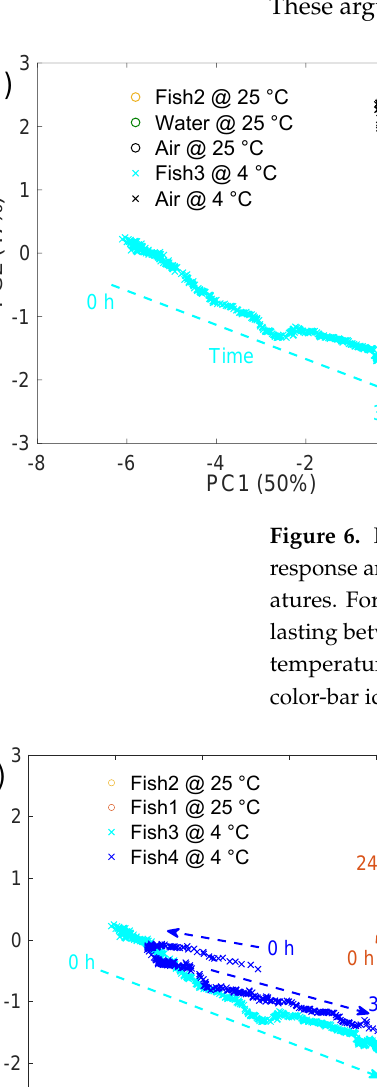
Figure 6. Principal component analysis (PCA) plot showing the time dependence of the device re- sponse and its correlation with selected air, water, and fish samples measured at different temper- atures. For the sake of clarity, only five samples are shown; each sample is measured for a period lasting between 24 and 36 h. ( a ) Colors and symbols are used to distinguish different samples and temperatures, respectively. Dashed arrows indicate the time direction for fish samples. ( b ) The color-bar identifies the measurement time for all samples, symbols identify different samples.